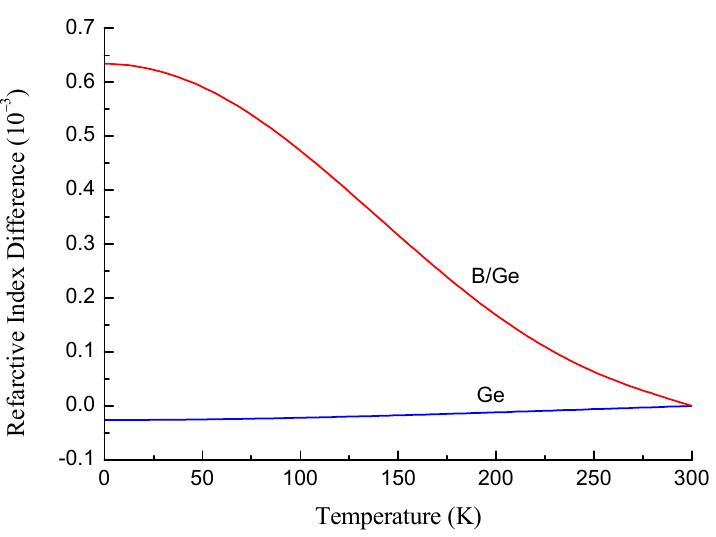
Figure 3. Refractive index difference between Ge- and B/Ge-doped silica and pure silica as a function of temperature.